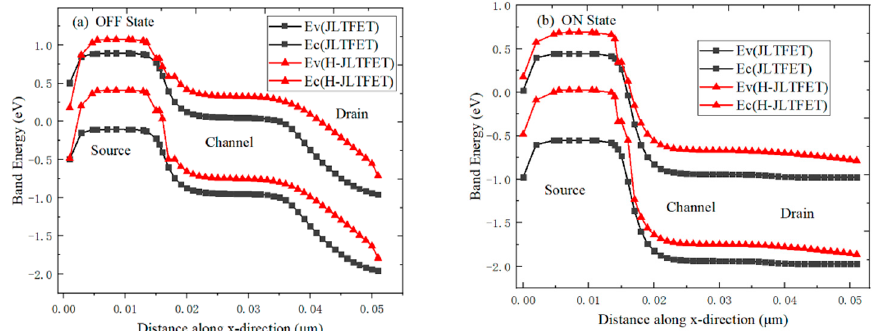
Figure 4. ( a ) Energy band diagram under the off-state; and ( b ) energy band diagram under the on-state.